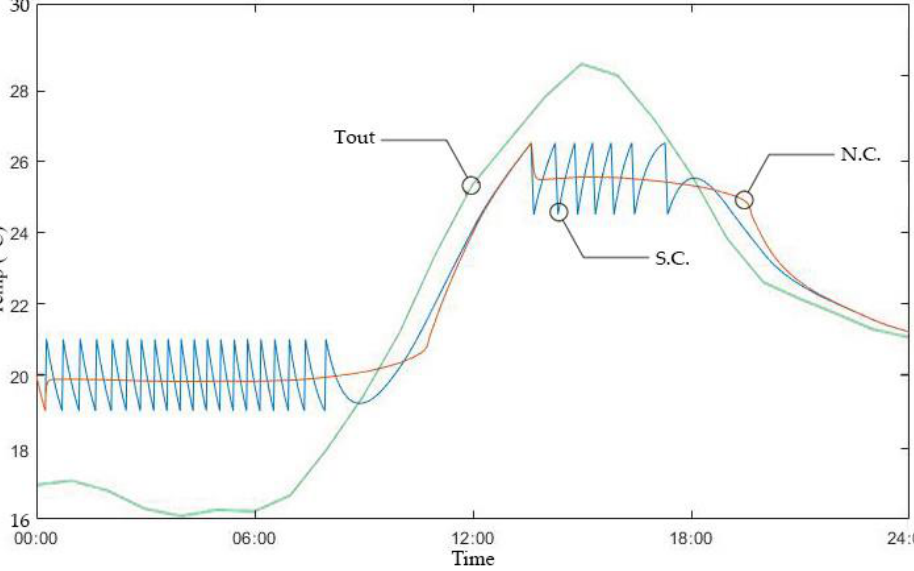
Figure 6. Comparison of T room between S.C. and network-based controller (NC).